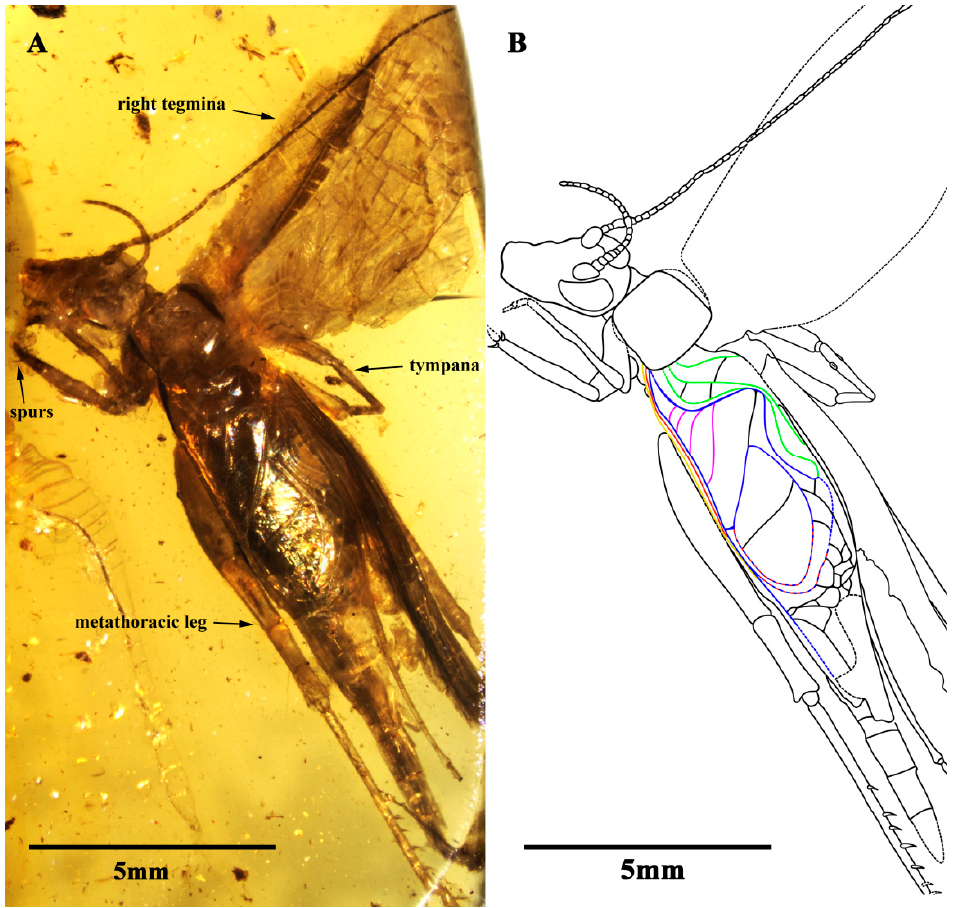
Figure 1. Habitus of B. haplostichus sp. nov.: ( A ) photograph of dorsal view, ( B ) line drawing of dorsal view. (Description of the color lines in ( B ): the yellow line represents radius vein (R); the red line represents media vein (M); the blue lines represent cubitus veins (CuA, CuP); the green lines represent anals veins (1A, 2A and 3A); and the pink lines represent oblique vein (o)).